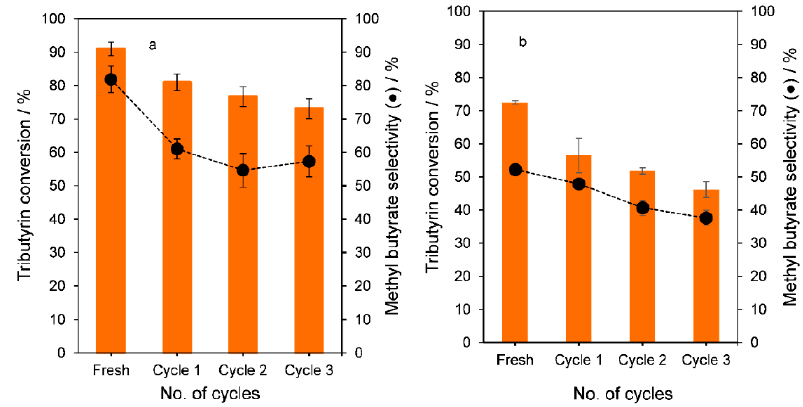
Figure 8. Tributyrin conversion and methyl butyrate selectivity as a function of recycle over: ( a )